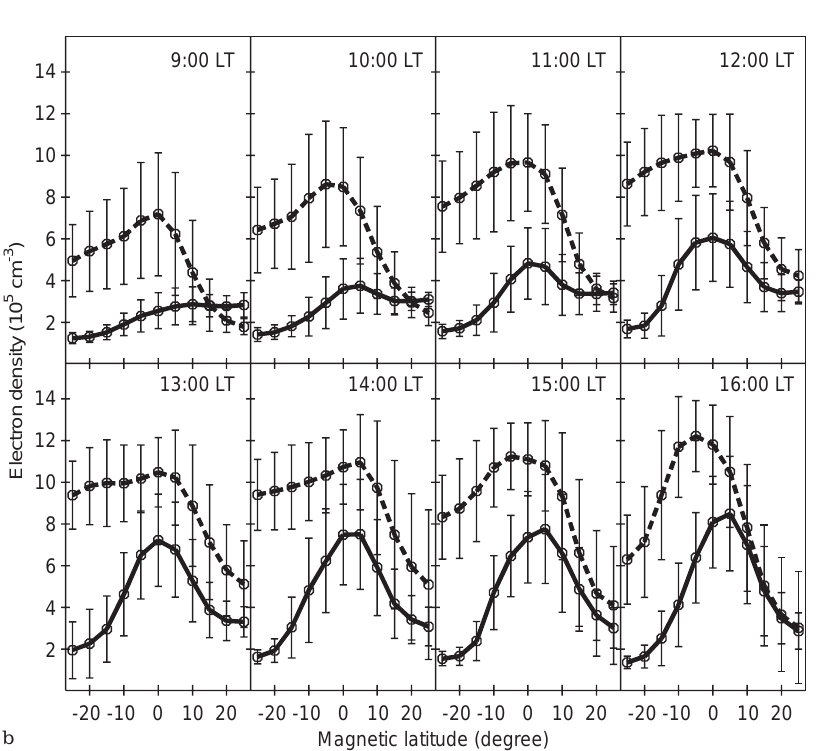
Fig. 1a–c. Latitudinal variations of the aver- age observed electron density for June solstice ( solid curves ) and December solstice ( dashed curves ) a at 01:00–08:00 LT. b 09:00–16:00